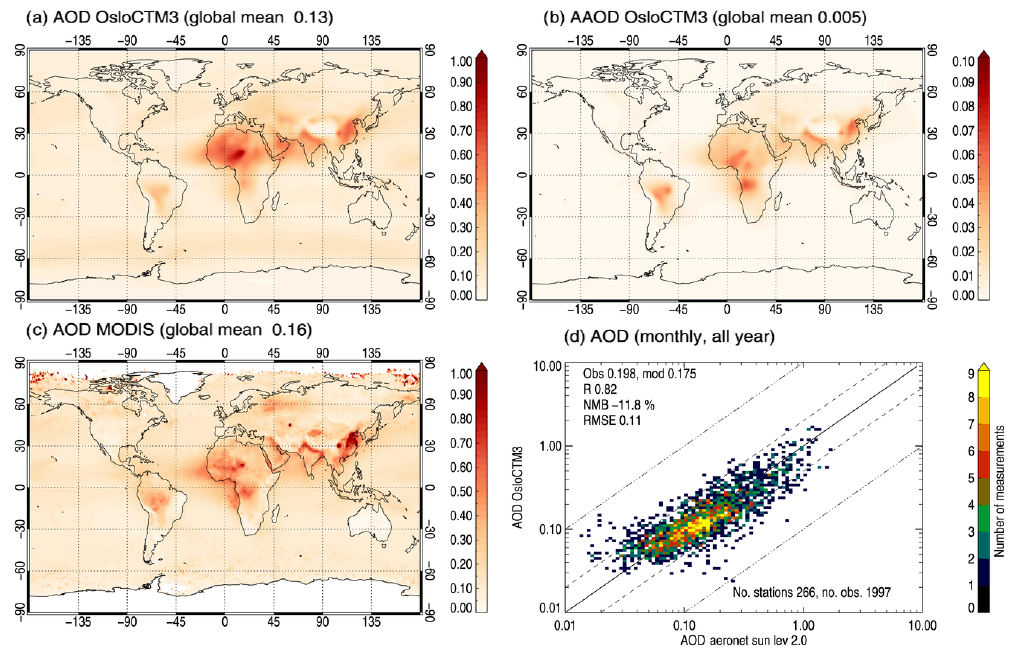
Figure 3. Annual mean (year 2010) modeled (a) AOD and (b) AAOD, (c) MODIS-Aqua AOD retrieval, and (d) scatter density plot of the comparison of simulated AOD against monthly mean AERONET